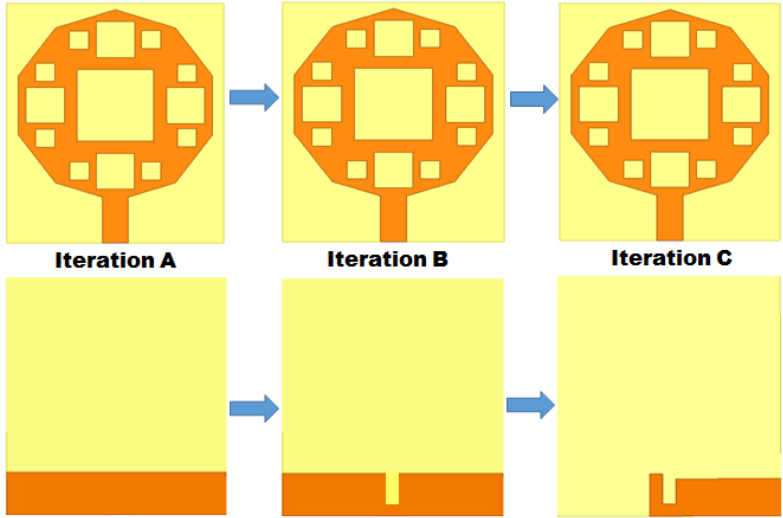
Figure 6. Different iterations of ground plane truncation.